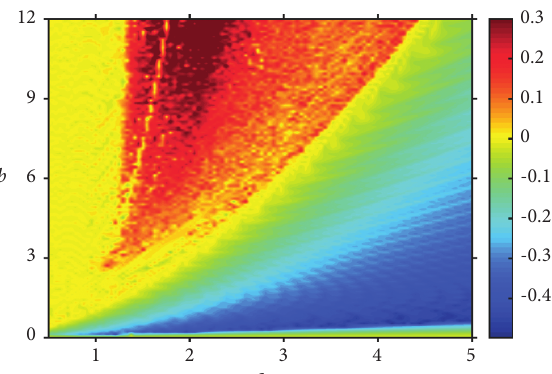
Figure 2: Division of parameters a and b by a pseudocolored